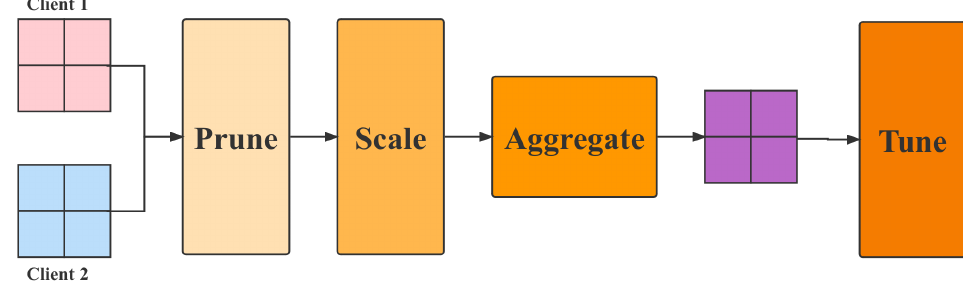
Figure 5. The flowchart of dual-ended personalized federal